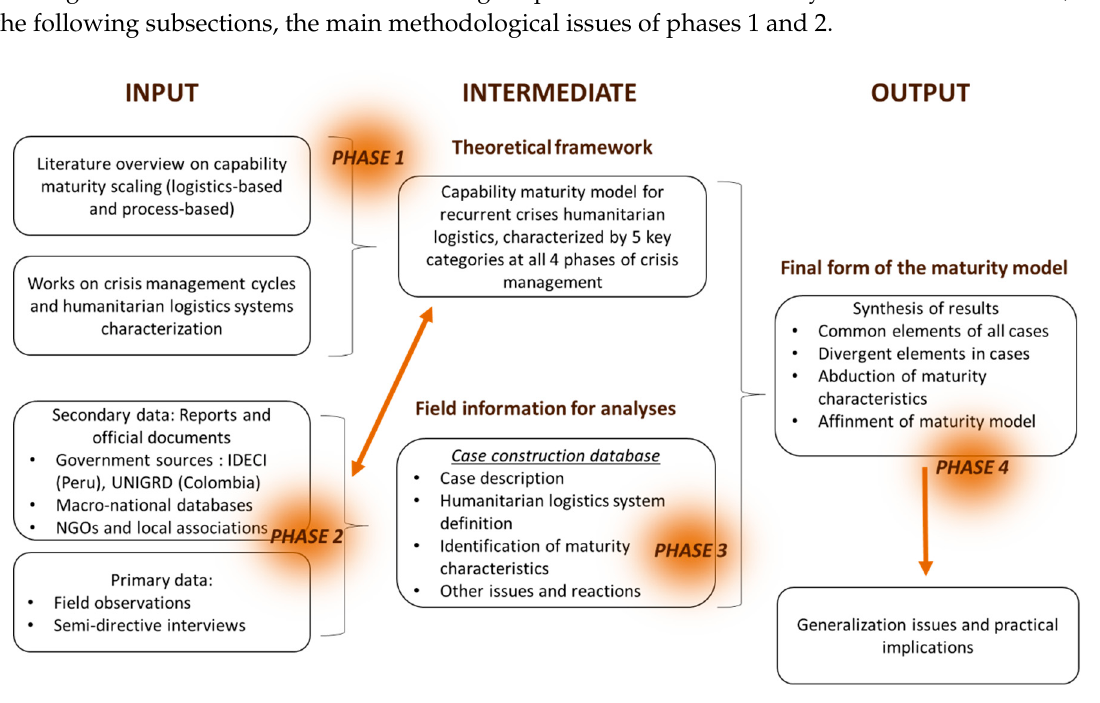
Figure 2. Methodological procedure for maturity assessment.